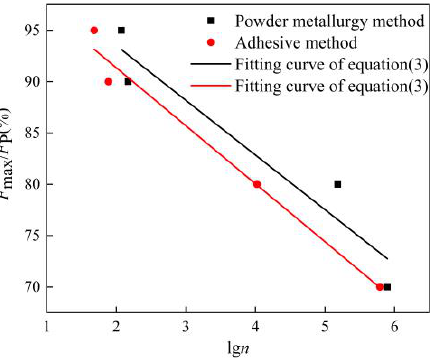
Figure 6. Fatigue life curves of AFSs made by different preparation methods.